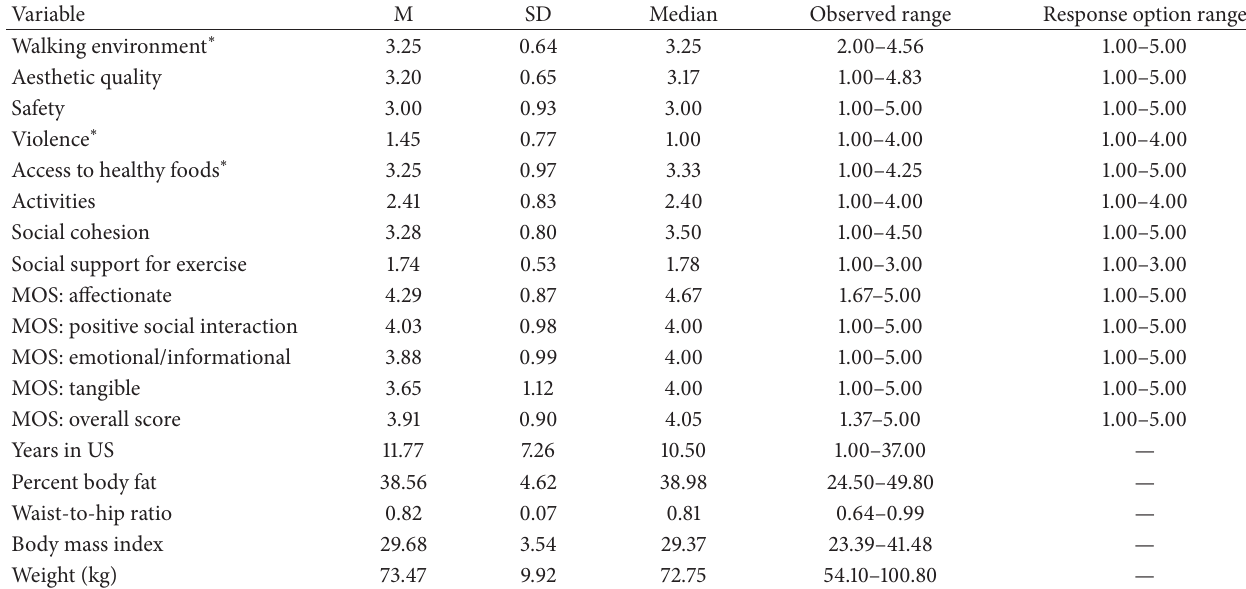
Table 1: Measures of central tendency and dispersion for neighborhood environment, social support, acculturation, and obesity-related